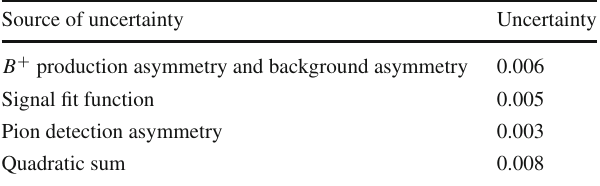
Table2 Systematicuncertaintiesonthedirect CP asymmetryof B + → J /ψ ρ + decays Source of